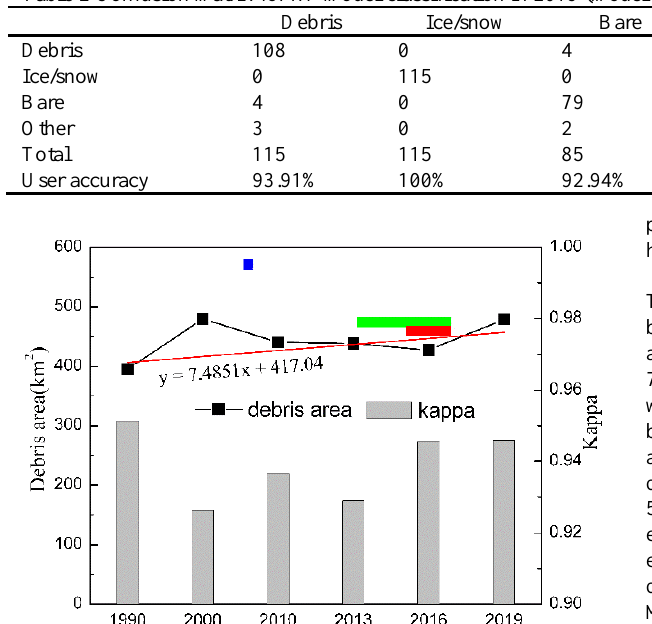
Figure 4. Debris cover area of the study area in different periods. Black represents estimates by the RF classifier in this paper. The grey histogram represents the estimation accuracy (Kappa coefficient) of the RF model for the corresponding period.